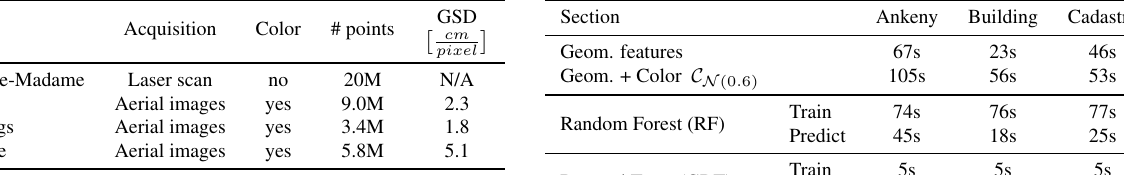
Table 2. Point cloud datasets used for evaluation.